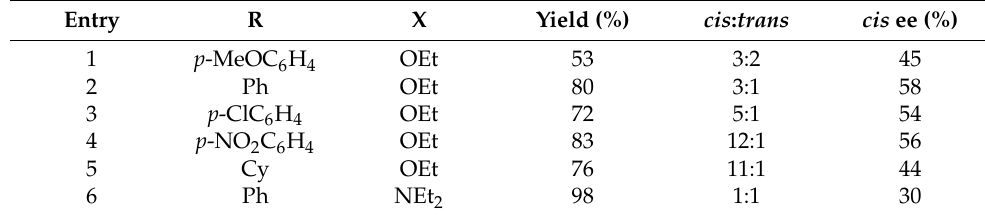
Table 7. Scope of asymmetric aziridination of diazoesters and diazoacetamides (Scheme 27). Entry R X Yield (%) cis : trans cis ee (%)